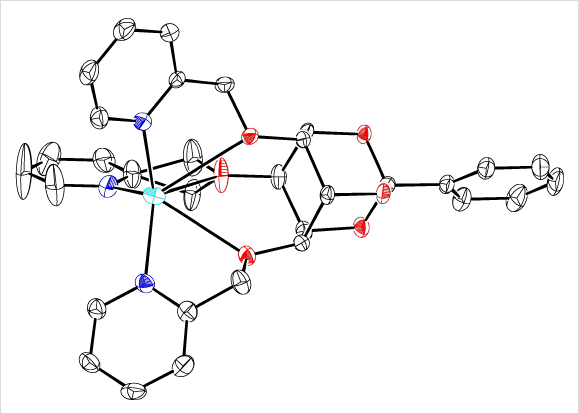
Figure 3: ORTEP drawing for the 1 ·Ag(I) cation complex (ellipsoids are drawn at the 50% probability level and H atoms are omitted for